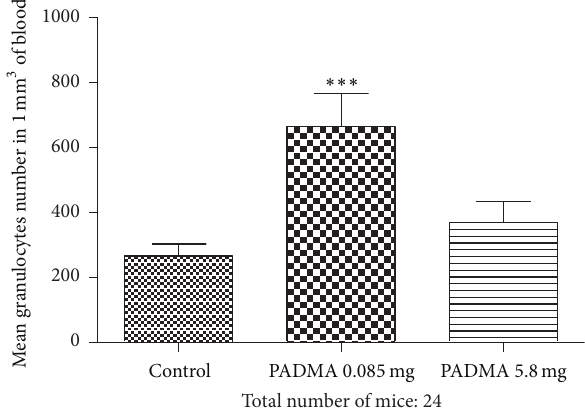
Figure 3: Effect of PADMA 28 (0.085 or 5.8 mg) supplementation on the number of blood granulocytes in mice. Balb/c mice were fed daily with 0.085 mg or 5.8mg PADMA 28. After 7 days mice were bled and sacrificed. Counting of leukocytes and blood smears examination were performed by routine methods. ∗∗∗ 𝑃 < 0.001 .